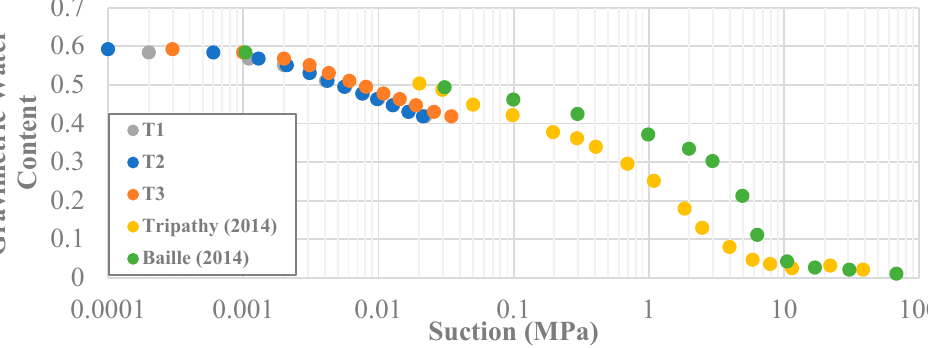
Figure 6. Soil Water Retention Curve for plain kaolinite. Other data are shown for comparison [43,44].